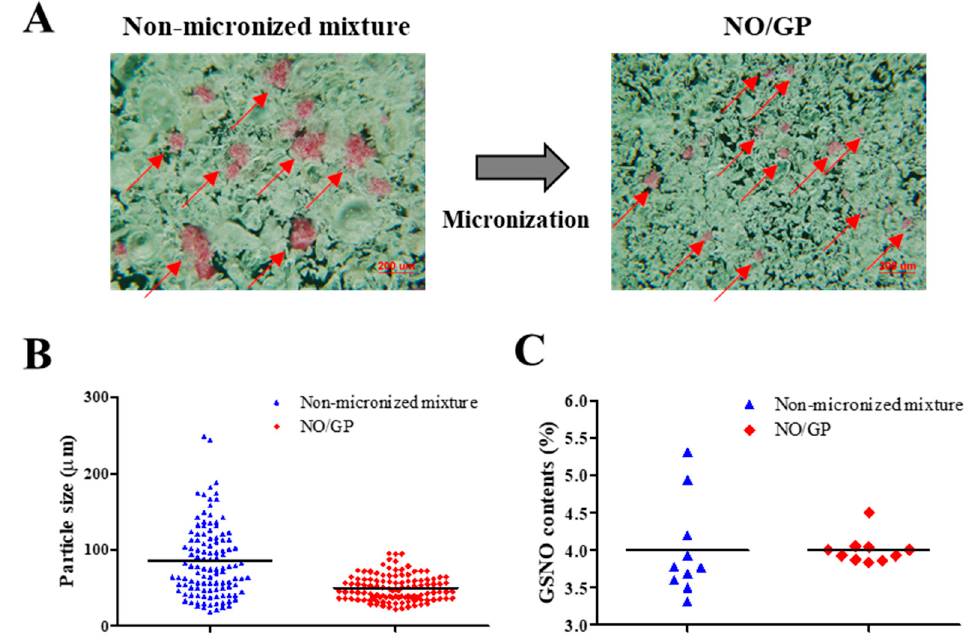
Figure 1. Characterization of NO / GP in powder form. Microscopic images ( A ), particle size distribution ( n > 100) ( B ), and S-nitrosoglutathione (GSNO) contents of non-micronized mixture and NO / GP ( n = 10) ( C ). Red arrows indicate GSNO particles (pink particles).